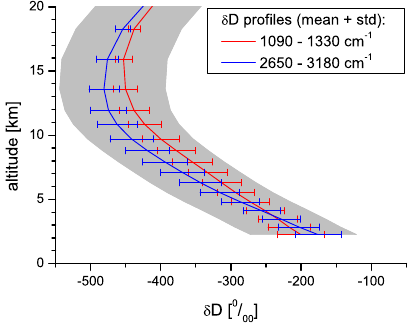
Fig. 15. Statistics of subtropical δ D profiles: Grey area: 1 σ range of δ D measured typically in the subtropics (Ehhalt, 1974; Zahn, 2001); Lines and error bars: mean and 1 σ standard deviation of the 325 MOHAVE-2009 FTIR retrievals; Red: in the 1090 - 1330 cm − 1 region; Blue: in the 2650 - 3180 cm − 1 region.